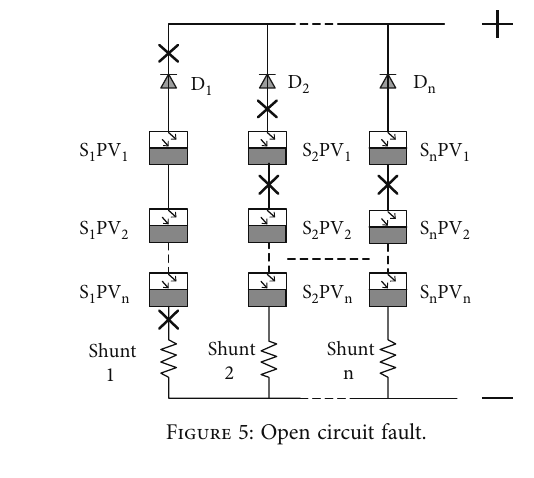
Figure 5: Open circuit fault.